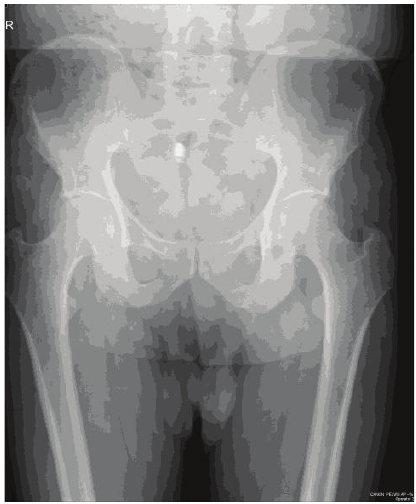
Figure 1: Anteroposterior plain radiograph of the pubis is normal.